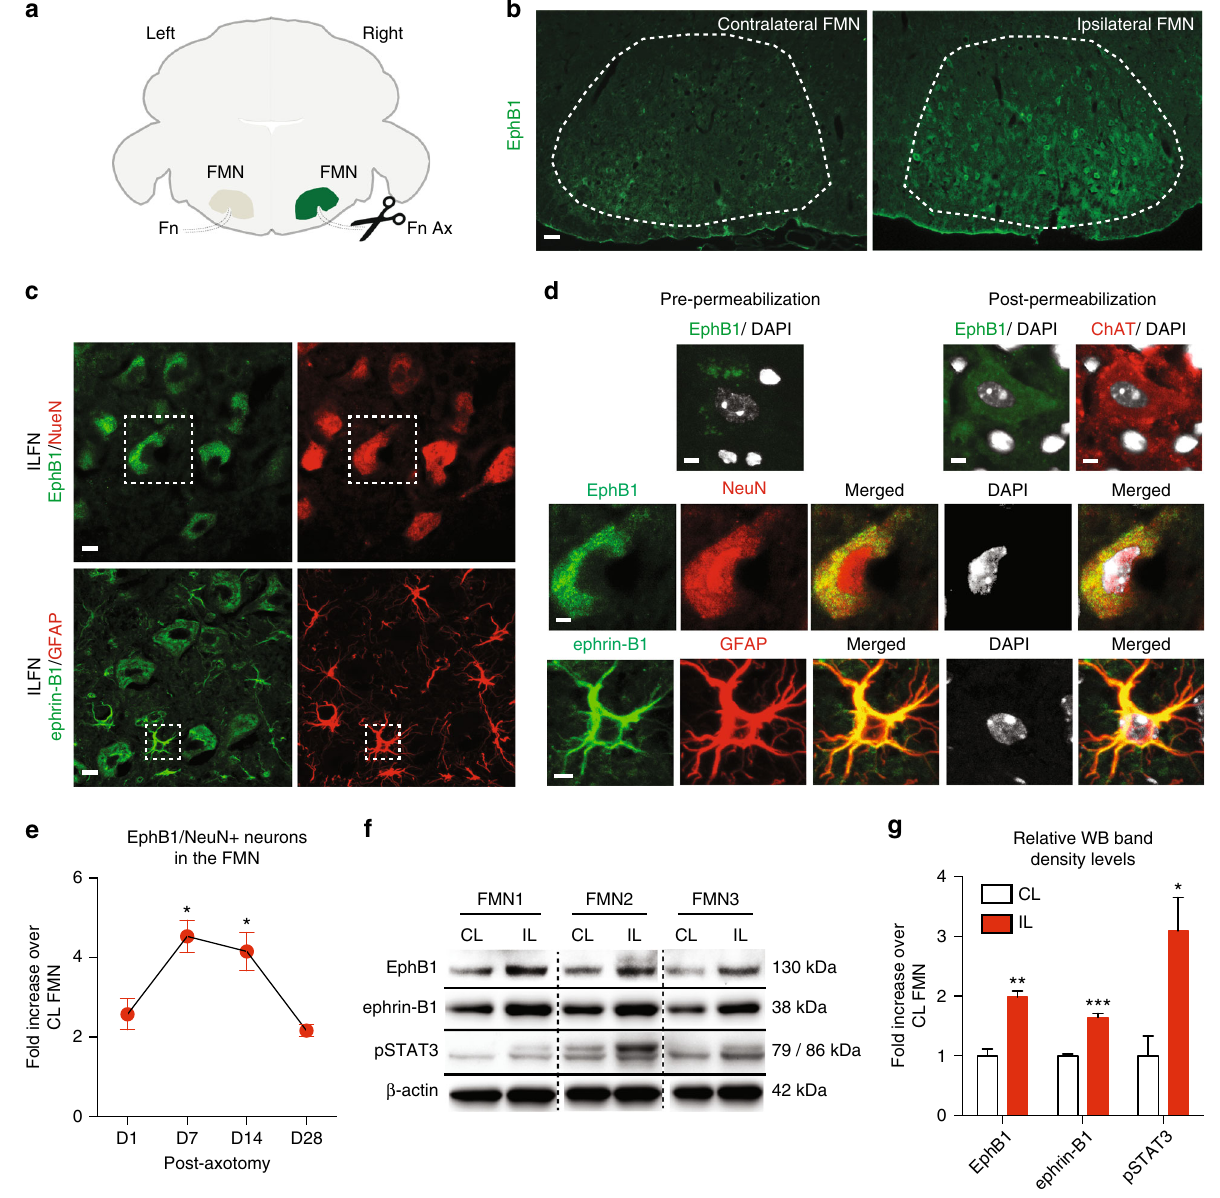
Fig. 1 EphB1 is upregulated in axotomised neurons, where astrocytes display ephrin-B1 IR. a Schematic diagram demonstrating right-sided unilateral facial nerve (Fn) axotomy (Ax) and the associated ipsilateral (IL) facial motor nucleus (FMN) in which immuno fl uorescence was analysed in comparison with the non-axotomised contralateral (CL) FMN. b Representative immuno fl uorescence images showing abundant EphB1 IR 14 days after axotomy in the IL FMN in which 98% of neurons are de fi ned as motor neurons 34 . c Images showing EphB1 and NeuN labelling and also ephrin-B1 and GFAP IR in corresponding neurons or astrocytes (ACs), respectively. d High magni fi cation images demonstrate cell surface labelling for EphB1 in sections immunostained before permeabilisation and also cytoplasmic EphB1 IR post-permeabilisation in a ChAT-positive motor neuron (MN) (see also Supplementary Fig. 1) and NeuN positive neurons with motor neuron morphology 32 in the middle panel. In the lower panel ephrin-B1 positivity is demonstrated in GFAP-labelled astrocyte soma and processes (see also Supplementary Fig. 1). e Graph showing the mean of fold changes in the proportion of EphB1-positive neurons in the IL FMN normalised to the CL FMN following axotomy (1, 7, 14, 28 days; n = 3 per time point, respectively, and 3 – 4 brainstem sections in each group; * p = 0.016, * p = 0.046 compared to values at day 1, F = 9.431; one-way ANOVA with Dunnett ’ s post hoc test; see also Supplementary Fig. 1). f Western blot (WB) showing EphB1, ephrin-B1 and pSTAT3 protein levels (both 79 and 86 kDa isoforms) in tissue lysates from both the IL and CL FMN of three WT mice at day 14 post-axotomy (see also Supplementary Fig. 8). g Bar graph represent relative WB band densities of EphB1, ephrin-B1 and pSTAT3 in the IL FMN and is expressed as fold increase over the band density levels for the CL FMN after normalisation to β -actin ( n = 3 mice, unpaired t -test, ** p = 0.006, *** p = 0.0004, * p = 0.034). Data presented as mean ± SEM. Scale bars: 50 μ m for ( b ), 20 μ m for ( c ) and 10 μ m for ( d phosphorylation with a plateau between 5 – 10 μ g ml − 1 (Supple- compared to non-treated astrocytes, which was comparable to that seen for the canonical STAT3 activator IL-6 (Supplementary mentary Figs. 2e, g and 10). Guided by these fi ndings in our Figs. 2b,d and 10). Dose – response analysis within a range of following experiments we used 10 μ g ml − 1 of EphB1 for 5 h to − 1 induce astrocyte responses after 1 h of serum starvation if not 0.0001 to 10 μ g ml of EphB1 revealed dose-dependent